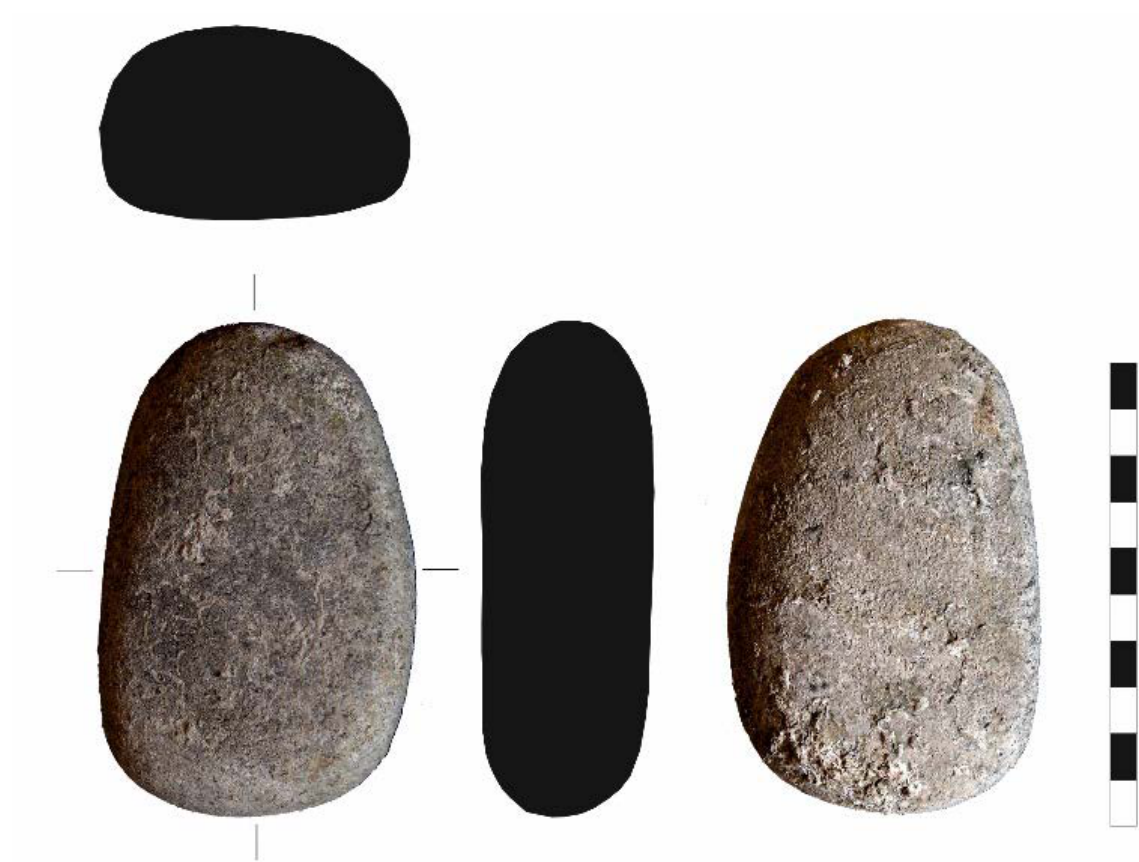
Figure 4. Handstone: workfaces, length and width sections (scale in